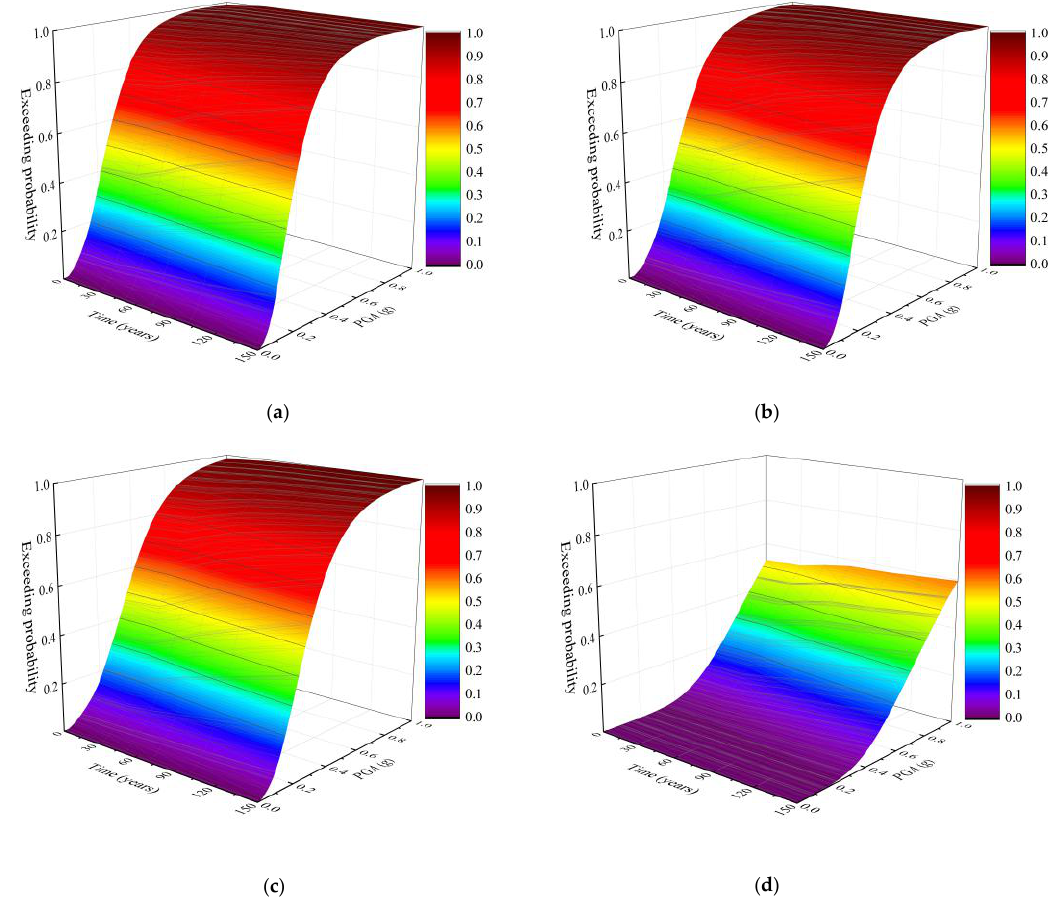
Figure 11. Fragility surface of the bridge system: ( a ) Slight damage; ( b ) Moderate damage; ( c ) Extensive damage; ( d ) Complete